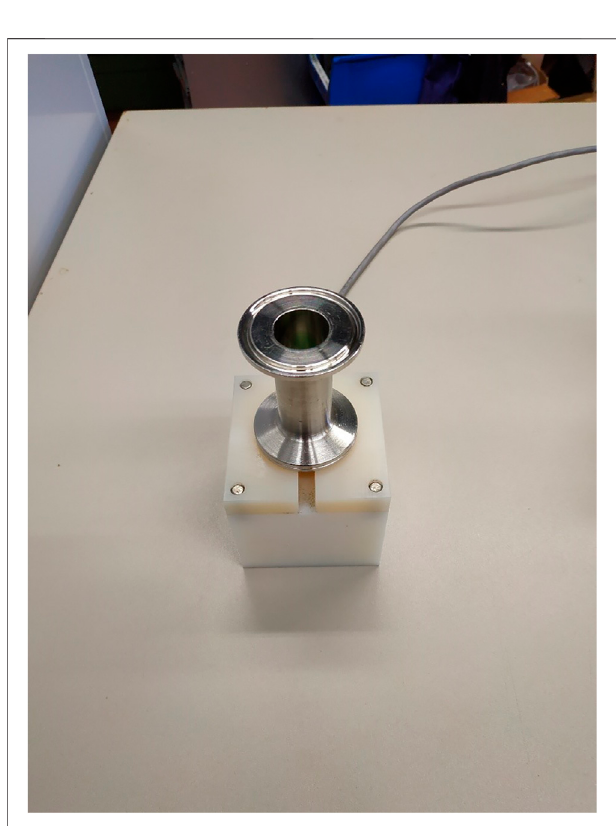
FIGURE 5 | MTPS setup with powder measurement